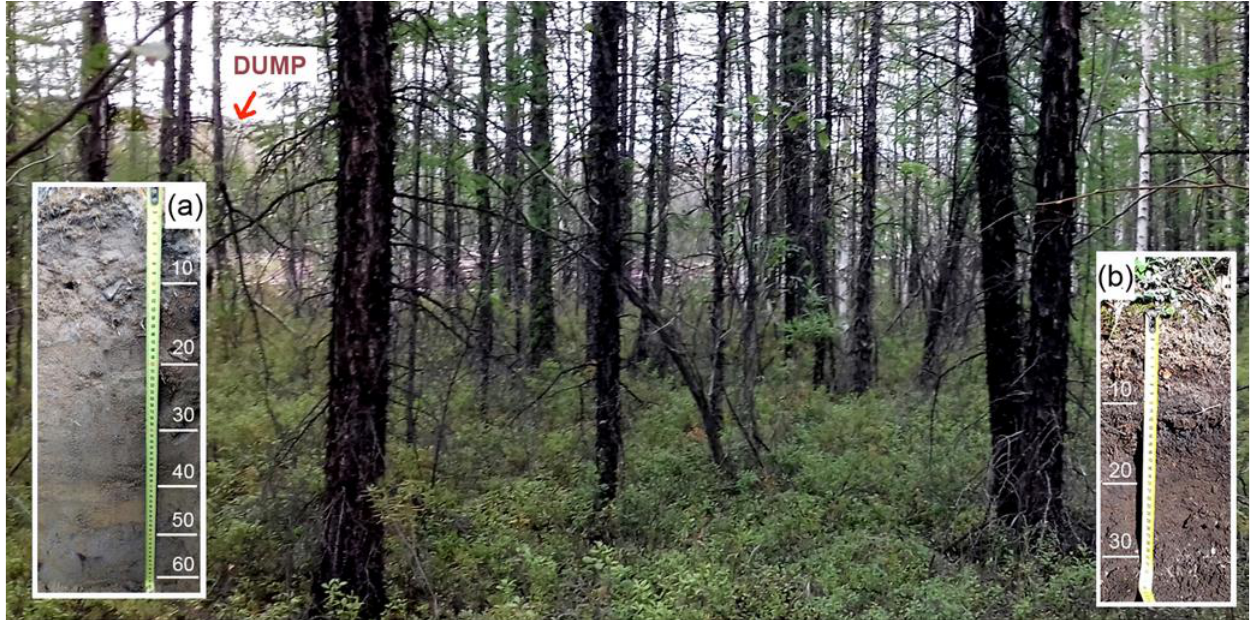
Figure 3. Sites of soil sections in the waste rock impact zone of the Botuobinsky tube quarry (photo by V. Boeskorov; date of photo: 17.08.2018): arrow—location of the waste dumpsite: ( a ) 50 m to West from the spoil dump—TSFs, H-61, 65 ◦ 00 (cid:48) 08.9 (cid:48)(cid:48) N, 117 ◦ 02 (cid:48) 35.2 (cid:48)(cid:48) E; ( b ) 100 m to the west from the